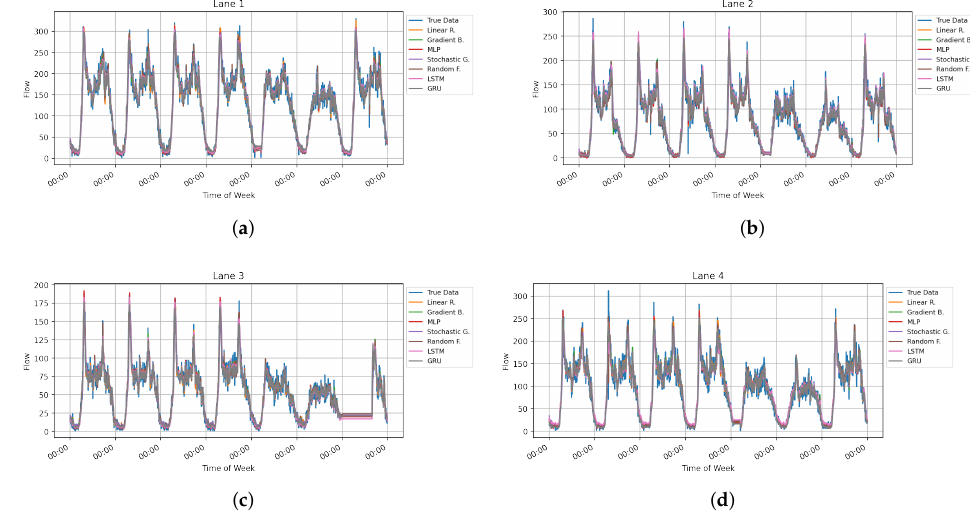
Figure 7. Comparison of traffic flow prediction models over an entire week. ( a ) Traffic flow prediction of lane 1; ( b ) Traffic flow prediction lane 2; ( c ) Traffic flow prediction lane 3; ( d ) Traffic flow prediction lane